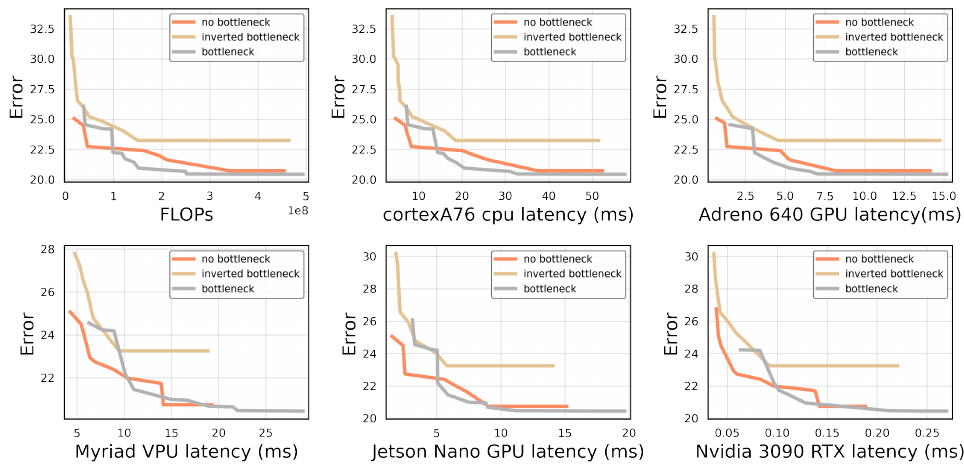
Figure 7. The bottleneck structure has little influence on the latency across all tested hardware platforms. The accuracy of inverted bottlenecks significantly lags behind building blocks with standard or no